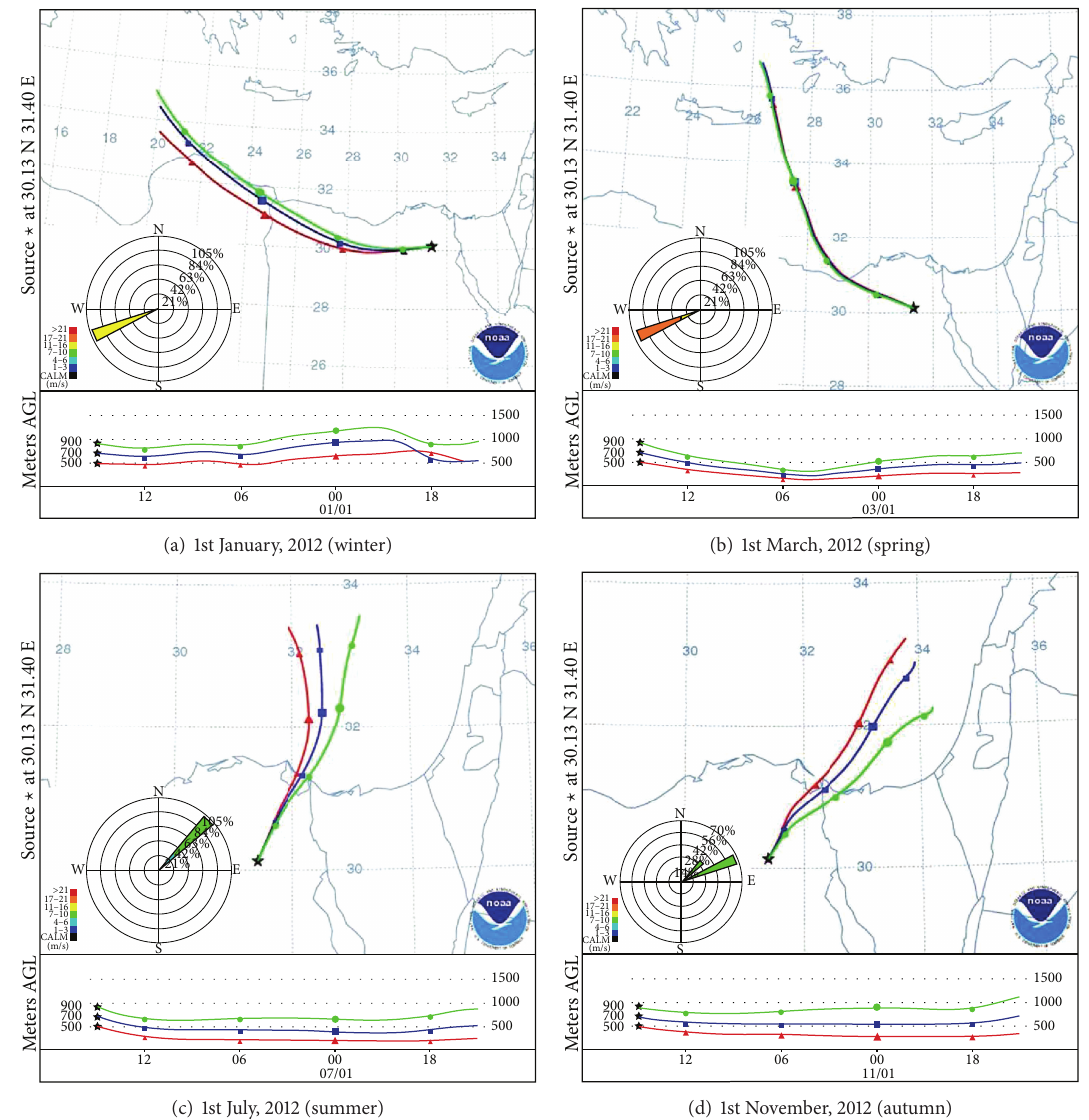
Figure 8: HYSPLIT and wind rose graphs for the four seasons in 2012. Three altitudes were considered: green 900m, blue 700m, and red 500 m. Win drose was generated at 950